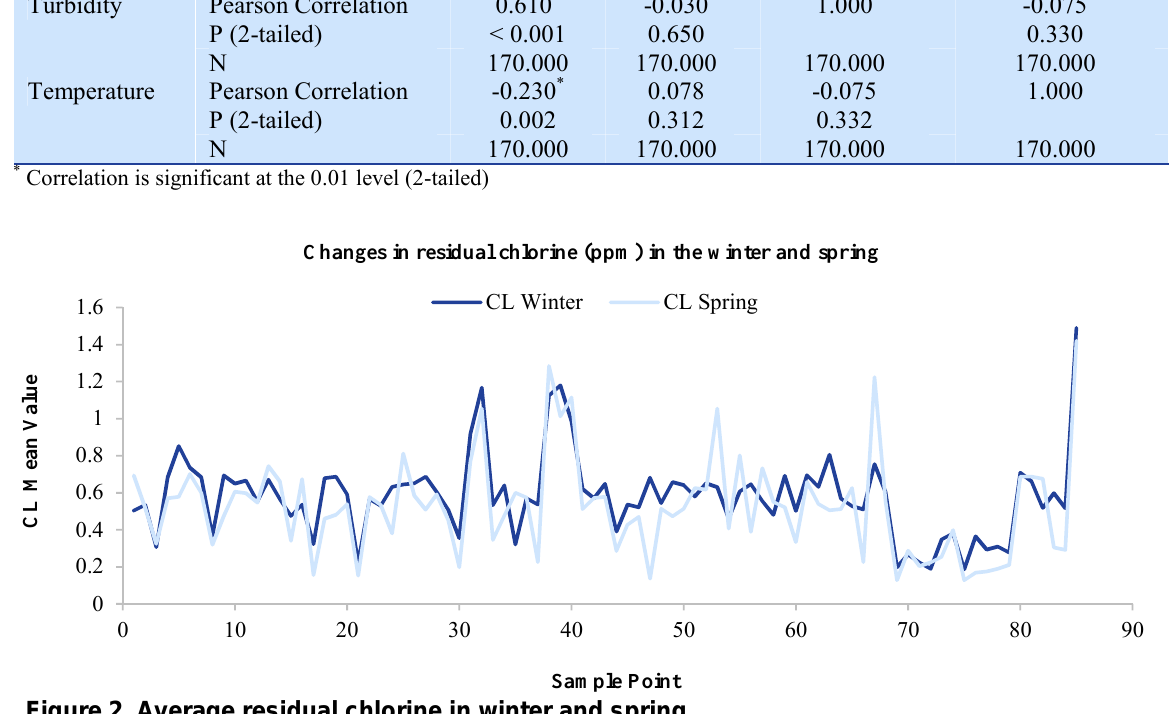
Figure 2. Average residual chlorine in winter and